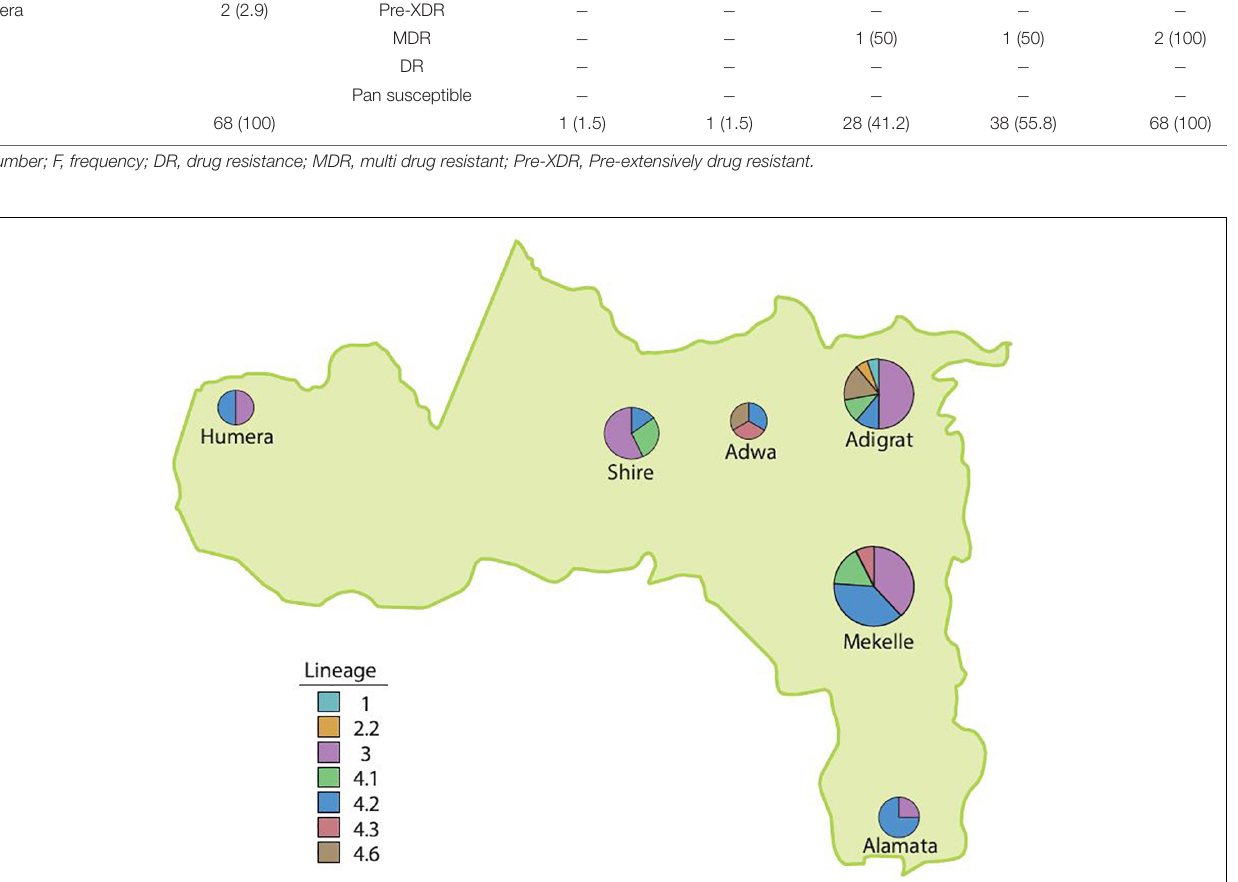
Frontiers in Microbiology |